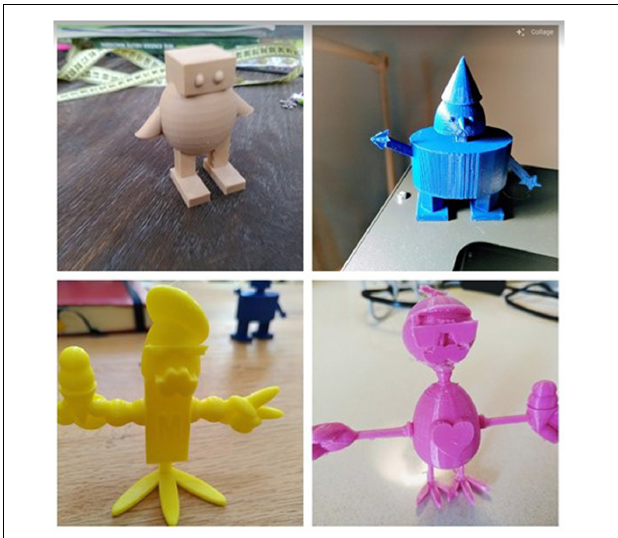
FIGURE 4 | Printed robots of the modeling